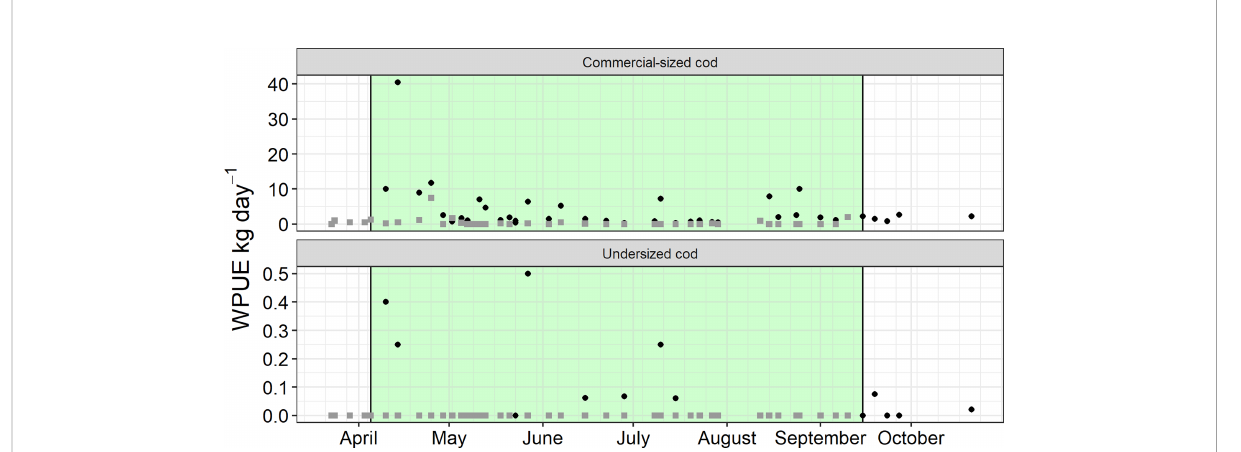
FIGURE 4 Mean WPUE (kg day -1 ) of commercial sized and undersized cod (Gadus morhua) in each of the two traps tested for difference in leader net mesh size. Black circles represent the pontoon trap with bottom set fi sh chamber, while grey squares represent the pontoon trap with fl oating fi sh chamber. Green background indicates the time period both traps were simultaneously used.